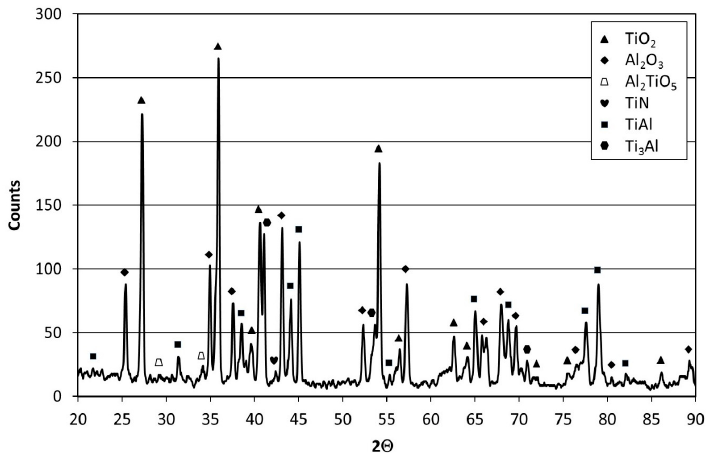
Figure 14. X-ray diffractogram of the oxide scale formed on aluminized Ti–45Al–8Nb–0.5(B, C) alloy after 100 oxidation cycles at 950 °C.